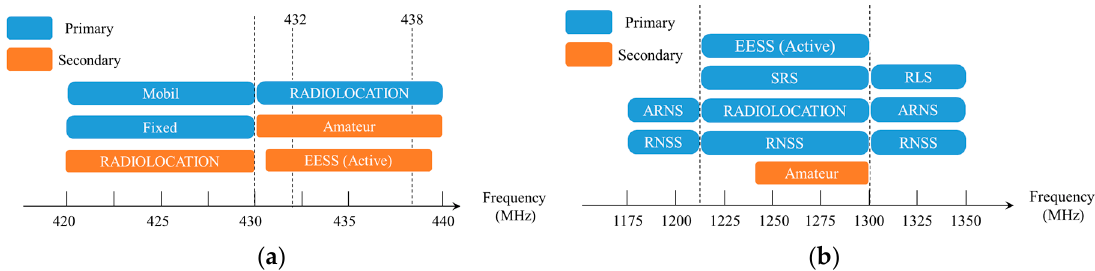
Figure 5. Illustration of allocated radio services in the vicinity of ( a ) P-band: 432-438 MHz and ( b ) L- band: 1215–1300 MHz.